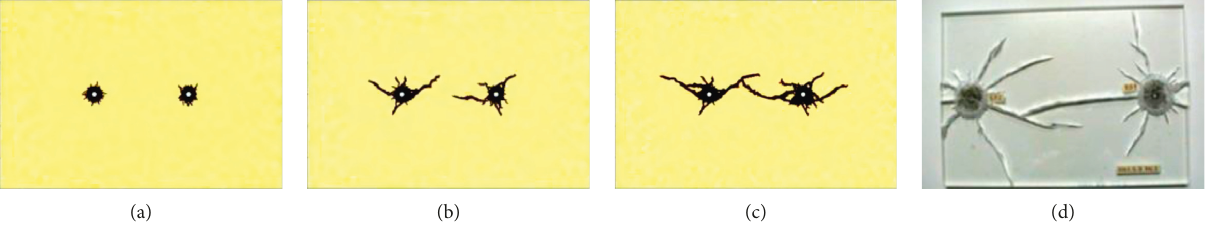
Figure 8: Numerical results on blasting-induced damage of rock specimens [205]: (a) step30_006; (b) step50_009; (c) step80_002; and (d) laboratory experiment.